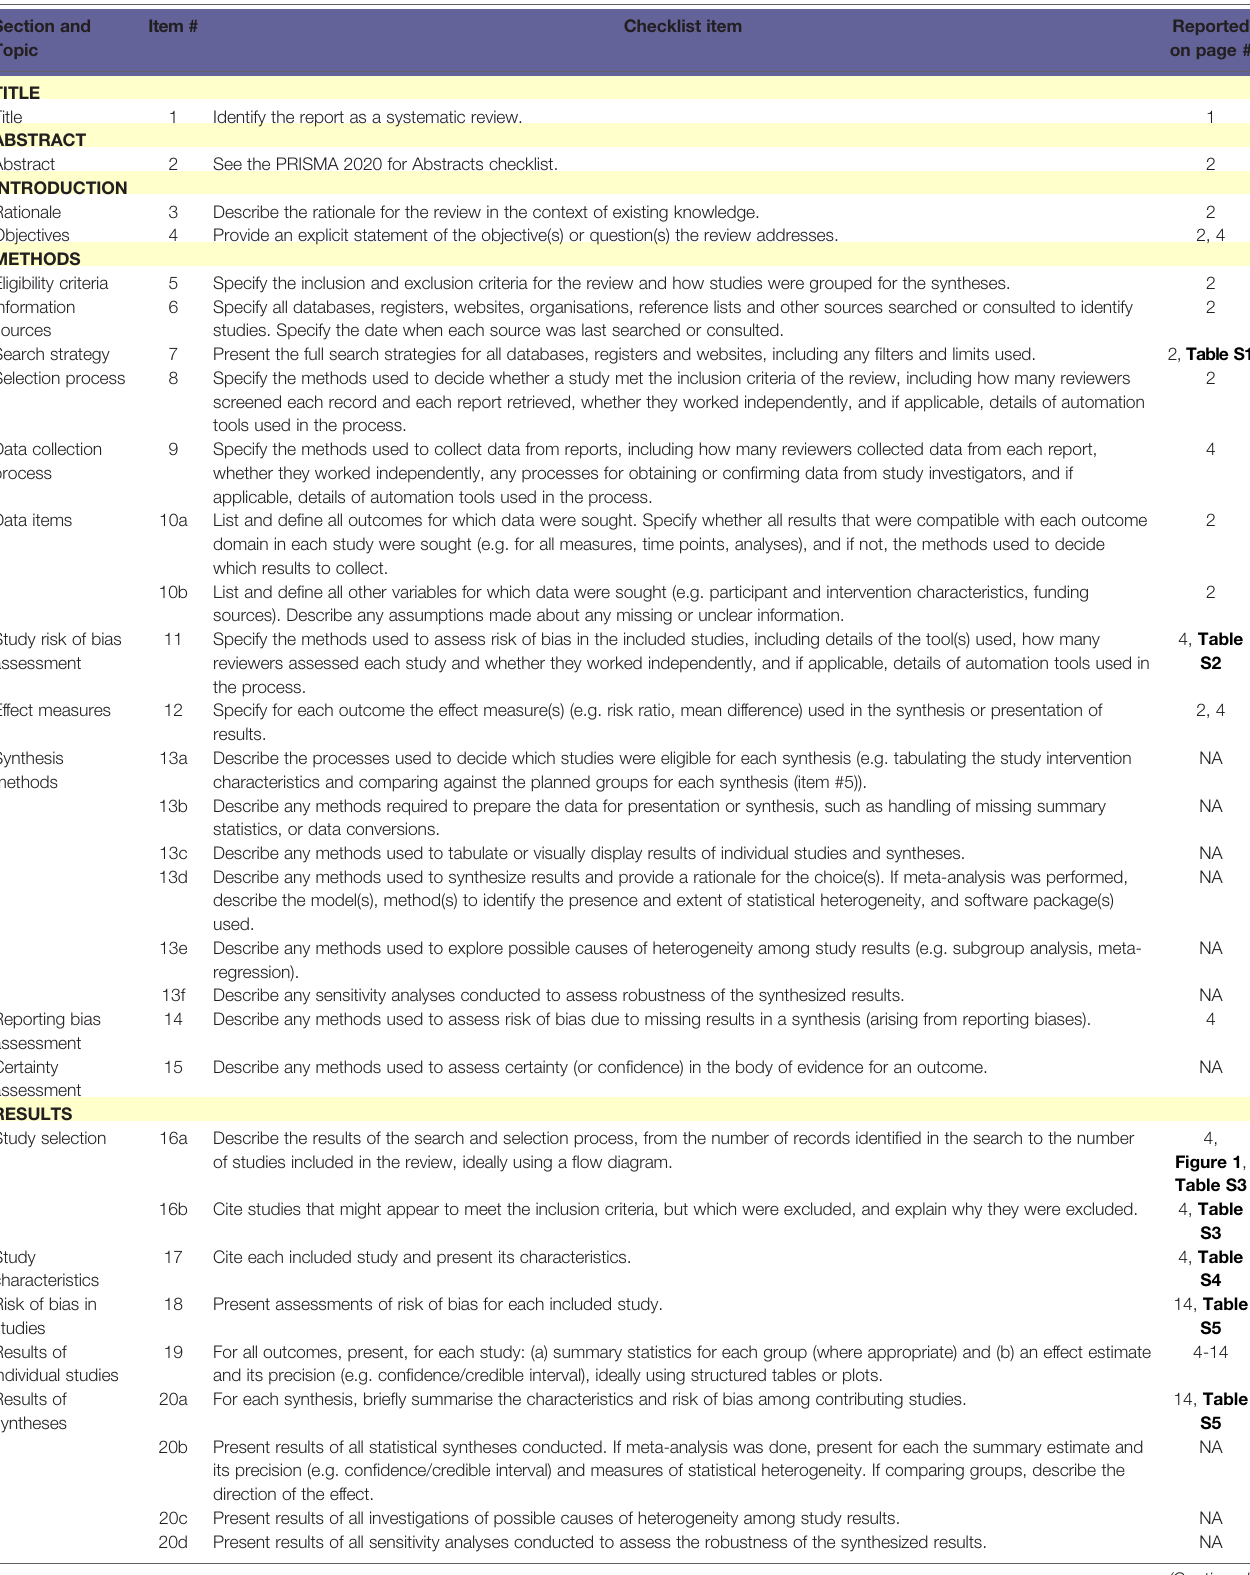
TABLE 1 | The Preferred Reporting of Systematic Reviews and Meta-Analyses (PRISMA)